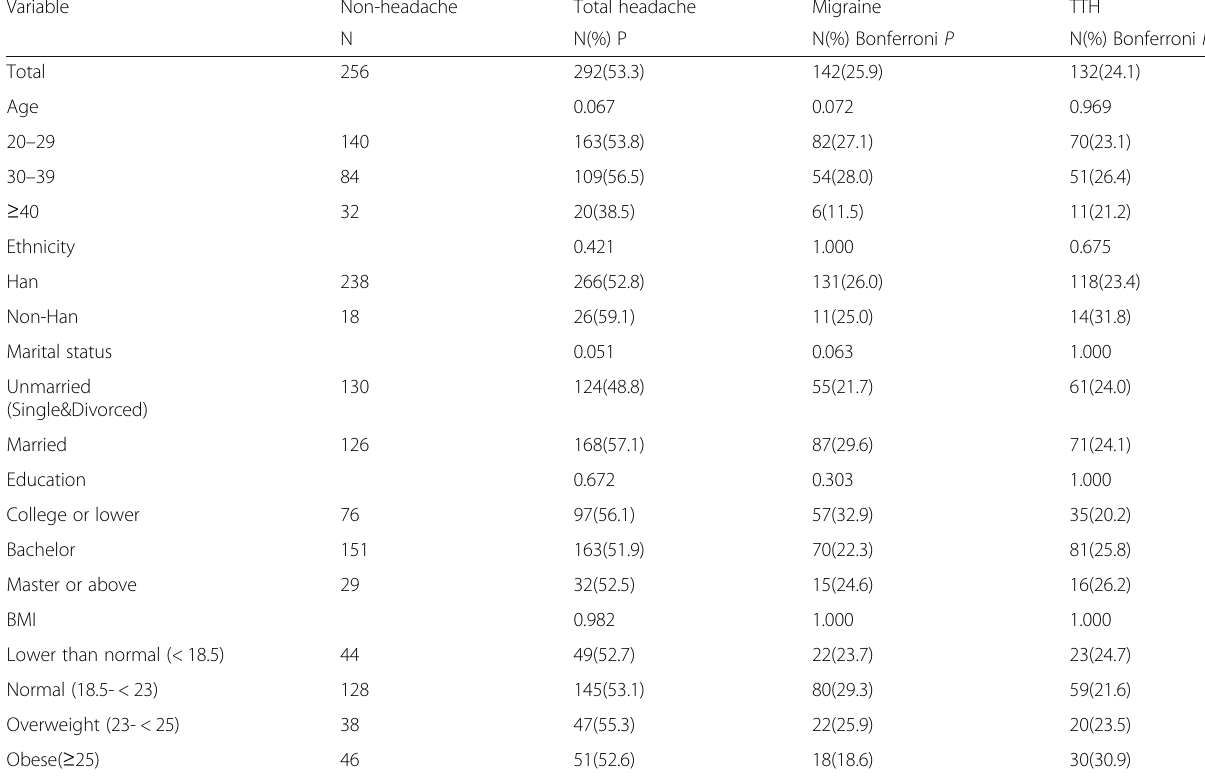
Table 1 The demographic characteristics comparisons between different types of headaches and non-headache among medical staff